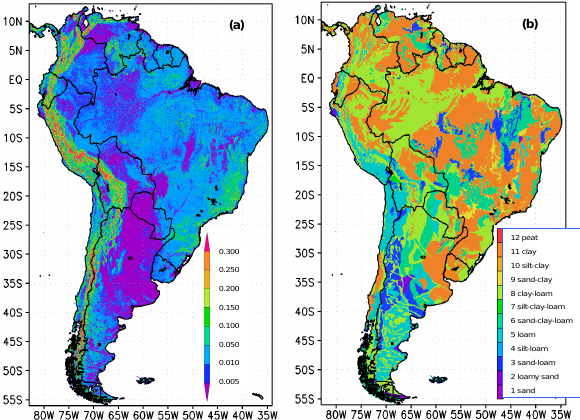
Fig. 4. (a) Terrain slope at 9 arc-second resolution, and (b) soil texture classes from GLDAS (Rodell et al., 2004).